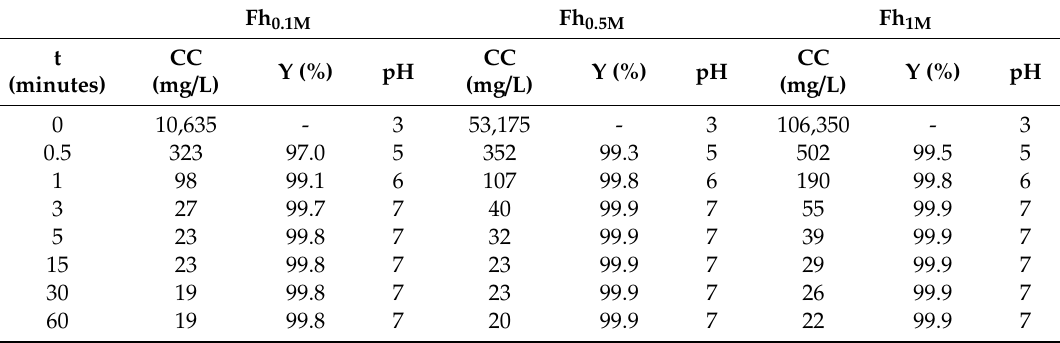
Table 1. Chloride concentration (CC), the yield of the production (Y) and pH values during the synthesis, at di ff erent times t from the beginning of the synthesis and for di ff erent reagents concentrations: 0.1 M, 0.5 M, and 1 M. Fh 0.1M Fh 0.5M Fh